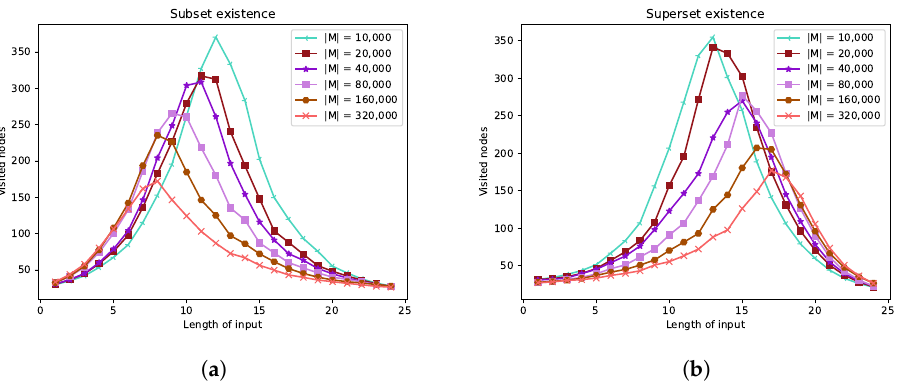
Figure 4. Existence functions of Experiment 1. ( a ) submsetExistence; ( b ) supermsetExistence. The maxima are located between 175 and 375 for SUBMSET E XISTENCE and between 175 and 350 for SUPERMSET E XISTENCE . According to these maxima, we can deduce that at least 7–15 multisets were checked in order to find a sub-multiset or super-multiset, which is from 0.02 × 10 − 3 to 1.5 × 10 − 3 of the multiset-trie and from 1.9 × 10 − 7 to 4.5 × 10 − 7 of the complete